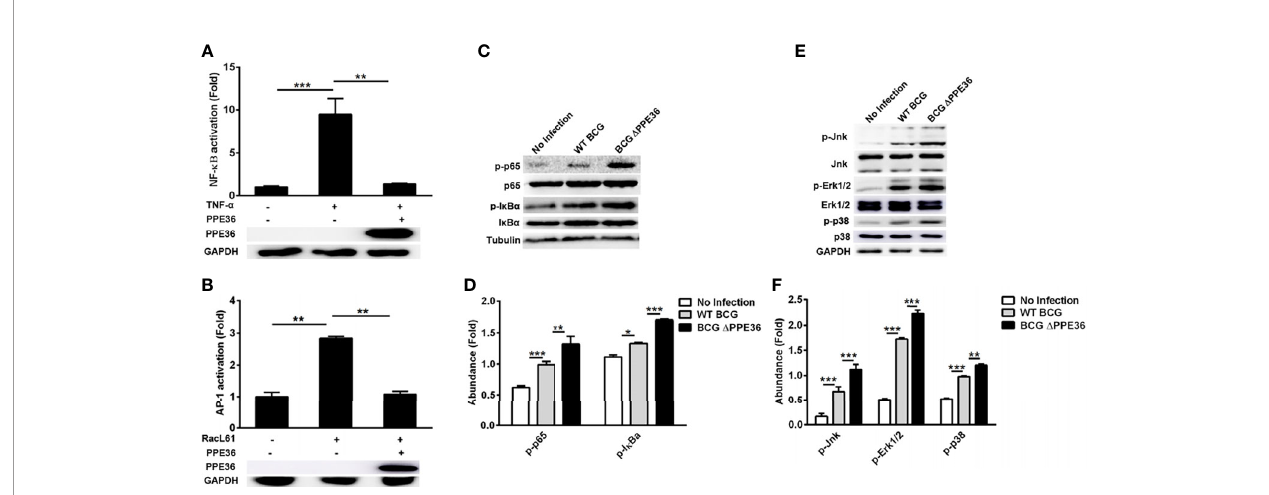
FIGURE 4 | PPE36 inhibited NF- k B and MAPK activation. (A) Luciferase assays of NF- k B activation in PPE36-overexpressing 293T cells after treating with TNF- a (20 ng/ml). (B) Luciferase assays of AP1 activation in PPE36-overexpressing 293T cells after transfecting pRacL61. (C, D) Western blot analysis of p-p65, p65, p-I k B a , and I k B a expression in WT BCG- or BCG D PPE36-infected RAW264.7 cells. (E, F) Western blot analysis of p-Jnk, Jnk, p-Erk1/2, Erk1/2, p-p38, and p38 expression in WT BCG- or BCG D PPE36-infected RAW264.7 cells. Densitometry quanti fi cation of Western blot results were analyzed by ImageJ. *p < 0.05, **p < 0.01, ***p <